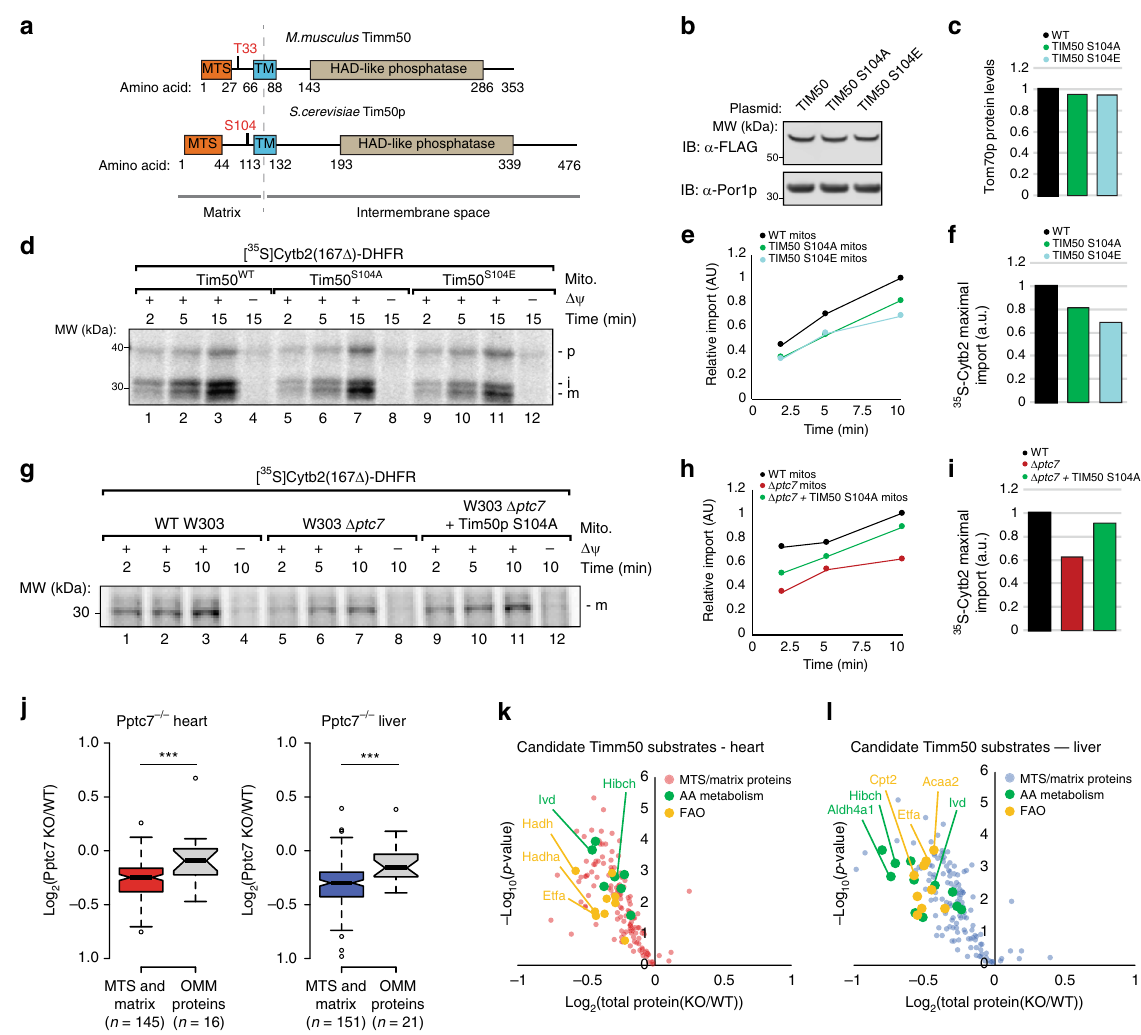
Fig. 5 Phosphorylation of Timm50 decreases mitochondrial protein import. a Protein domain schematic of mouse Timm50 (top) and yeast Tim50p (bottom) with highlighted phosphoresidues (red). b Western blot of overexpressed FLAG-tagged Tim50p WT, S104A, or S104E shows that mutations do not destabilize proteins. c Quanti fi cation of western blot for Tom70p protein levels (see Supplementary Figure 5F for corresponding western blot data). d Import assays in Δ tim50 yeast mitochondria overexpressing wild type (WT) TIM50 or S104 mutants using generic import cargo cytochrome b 2 - (167) Δ 19 -DHFR. Imported proteins result in accumulation of the mature (m) versus precursor (p) or intermediate (i) processed bands. Quanti fi cation of import rates is shown over time ( e ) and as maximal import signal ( f ) (AU densitometry at 10 min). g Import assays in mitochondria isolated from WT, Δ ptc7 , or Δ ptc7 overexpressing TIM50 S104A yeast using the matrix-targeted model substrate cytochrome b 2 -(167) Δ 19 -DHFR. Imported proteins result in accumulation of the mature (m) product. Quanti fi cation of import rates is shown over time ( h ) and as maximal import signal ( i ) (AU densitometry at 10 min). j Quanti fi cation of mitochondrial proteins in mouse heart (left) ( n = 145 for matrix proteins and n = 16 for OMM proteins) and mouse liver (right) ( n = 151 for matrix proteins and n = 21 for OMM proteins) showing signi fi cantly lower expression (*** = p < 0.001, as calculated by a two-tailed Student ’ s t -test) of candidate Timm50 substrates (e.g., MTS and matrix-containing proteins) than proteins that localize to the outer mitochondrial membrane (OMM). For box plots in j , center lines show the medians; box limits indicate the 25th and 75th percentiles as determined by R software; whiskers extend 1.5 times the interquartile range from the 25th and 75th percentiles, and outliers are represented by white dots. k , l Volcano plots of candidate Timm50 substrates in heart ( k ) and liver ( l ) show downregulation of metabolic proteins in amino acid metabolism and fatty acid oxidation, both of which are disrupted in Pptc7-null tissues (Fig. 2). Source data for panels b , d , g , and j – l are provided as a Source Data fi (Fig. 3). Timm50 is a core component of the Timm23 complex both heart and liver (Fig. 5j) KO tissues. These decreased proteins that translocates proteins possessing a mitochondrial targeting include those whose dysfunction is associated with various sequence (MTS) that are typically bound for the matrix 45 . We dysregulated metabolites we identi fi ed in Pptc7 KO tissues: hypothesized that if Timm50 was selectively impaired in Pptc7 Aldh4a1 (hyperprolinemia) 47 , Pcca, Pccb, Acad8, and Ivd (BCAA KO tissues, then matrix-localized MTS-containing proteins would and catabolite acylcarnitine accumulation) 48 , and Etfa and show greater decreases in our proteomics dataset relative to other Etfdh (medium and long-chain acylcarnitine accumulation) 35 mitochondrial proteins (e.g., proteins destined for the outer (Fig. 5k, l). Together, these data suggest that disruption of mitochondrial membrane (OMM)). Indeed, proteins that have Timm50-mediated import could broadly in fl uence metabolic both an MTS 46 and matrix localization 26 were signi fi cantly pathways, and may contribute to the widespread defects seen in decreased relative to the OMM-localized proteins we measured in the Pptc7 knockout mouse.